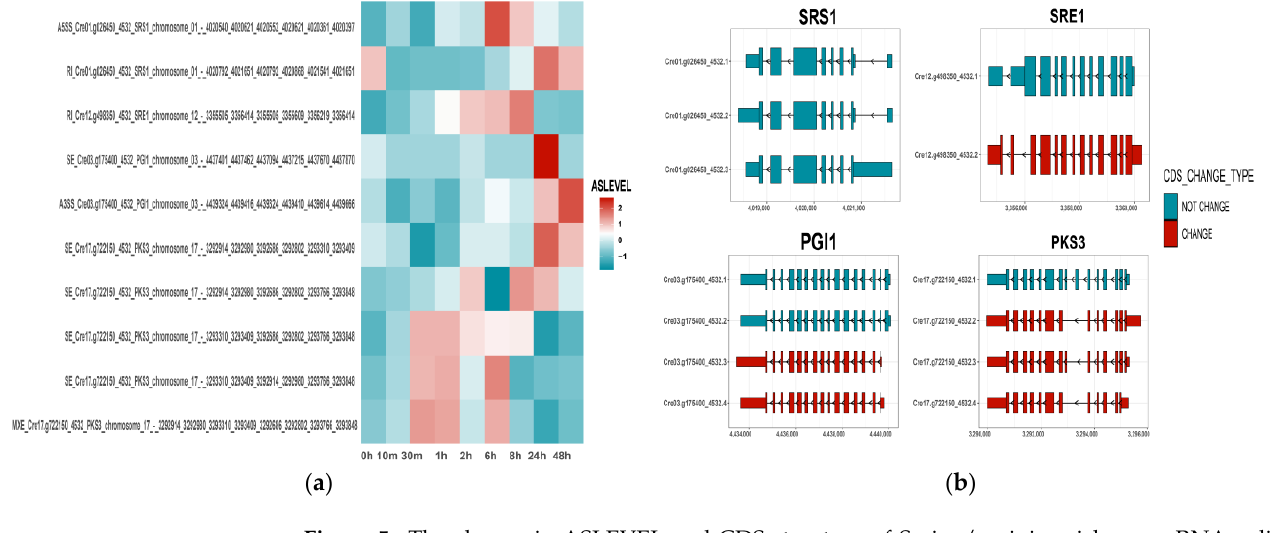
Figure 5. The change in ASLEVEL and CDS structure of Serine/arginine-rich pre-mRNA splicing factor (SRS1), SR-related Pre-mRNA splicing factor (SRE1), Phosphoglucose isomerase (PGI1), and Type III polyketide synthase (PKS3). ( a ) The ASLEVEL heatmap of AS event of SRS1, SRE1, PGI1, and PKS3. ( b ) The CDS structure change of SRS1, SRE1, PGI1, and PKS3. The narrow bars and wide bars represent the non-coding sequence and CDS structure of the transcript, respectively. Table 1. Lipid-related metabolic pathway gene annotation and AS events.